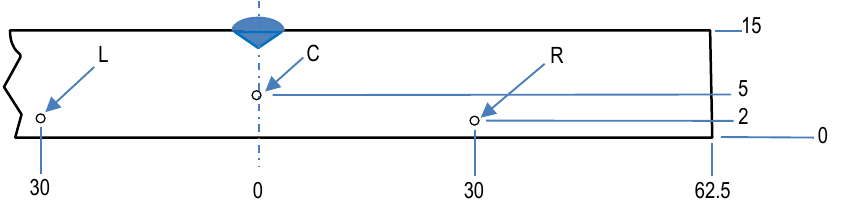
Figure 1a: Modified tensile specimen with three sawed slots. All dimensions are in millimeters.